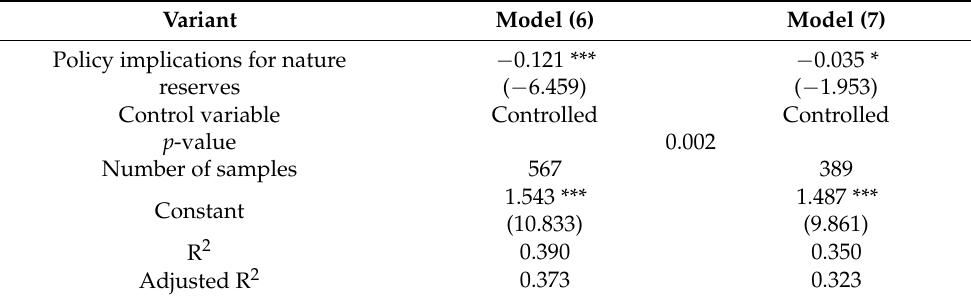
Table 7. SUR test